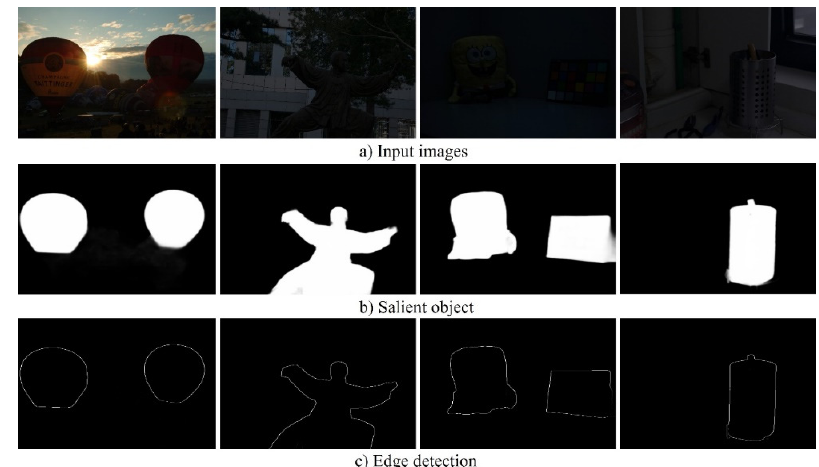
Figure 13. The results of the tactile graphics generation on LOL dataset. A refreshable 2D multiarray Braille display was used to dynamically represent the tactile graphics of salient objects. The tactile display has 12 × 12 Braille cells, and its simulator is illustrated in Figure 14. Further, the volume control buttons are located on the left side and can be used to adjust the volume of audio or TTS and the speed of the TTS can be increased or decreased with a long click. In addition, other buttons to control various tasks are included, as shown in Figure 14.